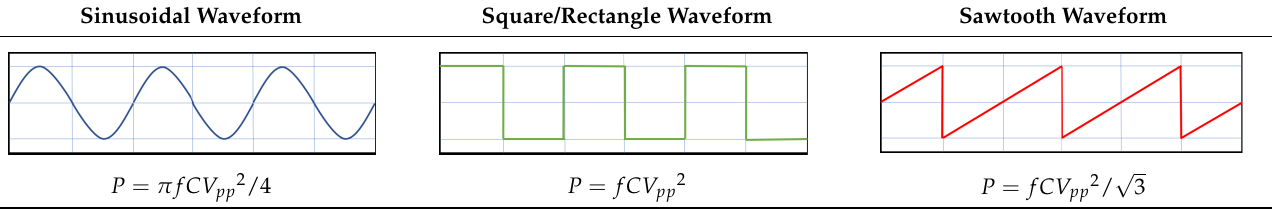
Table 3. Typical input signals and related power consumption for piezoelectric actuators. Sinusoidal Waveform